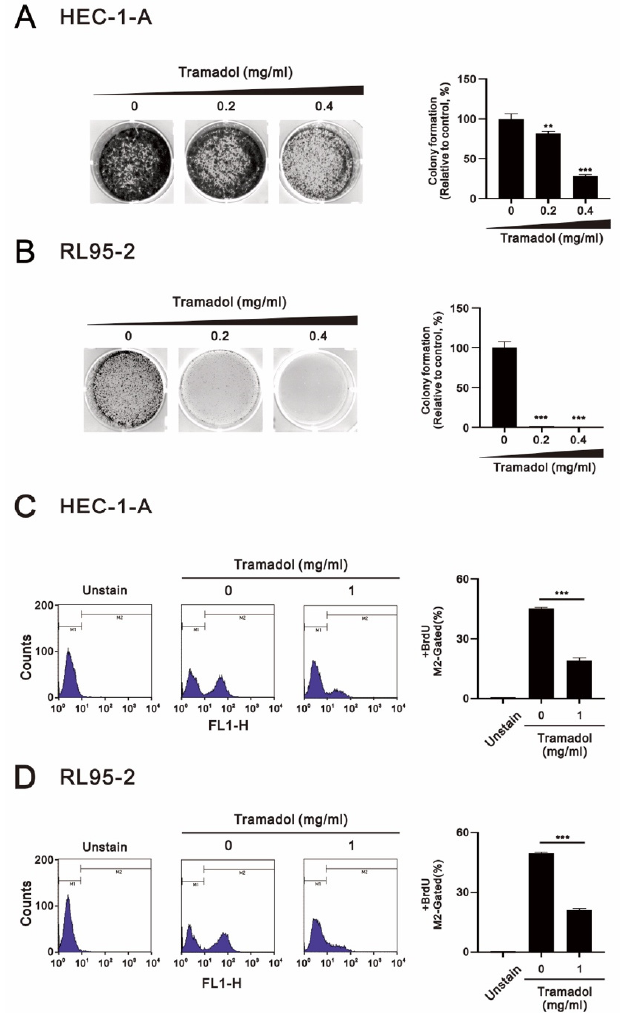
Figure 1. Effects of tramadol on proliferation in human endometrial cancer cells. ( A , B ) HEC-1-A and RL95-2 cells were treated with tramadol (0, 0.2, and 0.4 mg/mL) for 14 days. ( C , D ) HEC-1-A and RL95-2 cells were treated with tramadol (0 and 1 mg/mL) for 24 h. Cell proliferation was assessed using BrdU assay with flow cytometry. M2-gated shows the proportion of proliferating cells. Bars depict the mean ± SD of three independent experiments. Student’s t -tests were performed and the results were compared with the vehicle. ** p < 0.01, and *** p < 0.001 (Student’s t